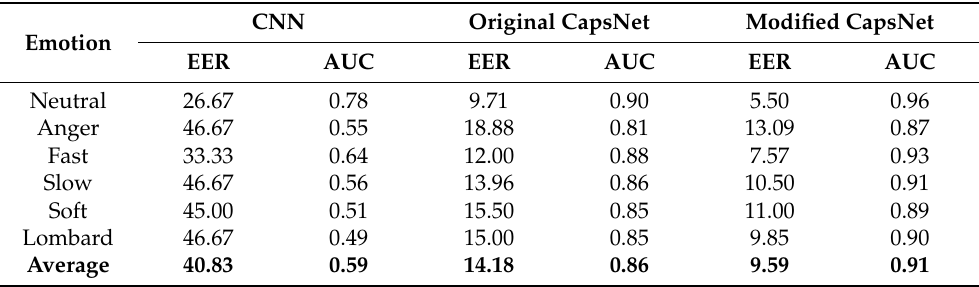
Table 6. Speaker verification performance in terms of EER and AUC of each of CNN, original CapsNet, and the proposed model using the SUSAS